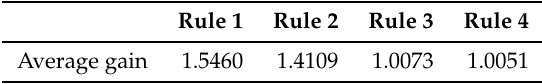
Table 2. The average gains for different rules: optimal (Rule 1), sub-optimal (Rule 2), deterministic (Rule 3) and random (Rule 4).